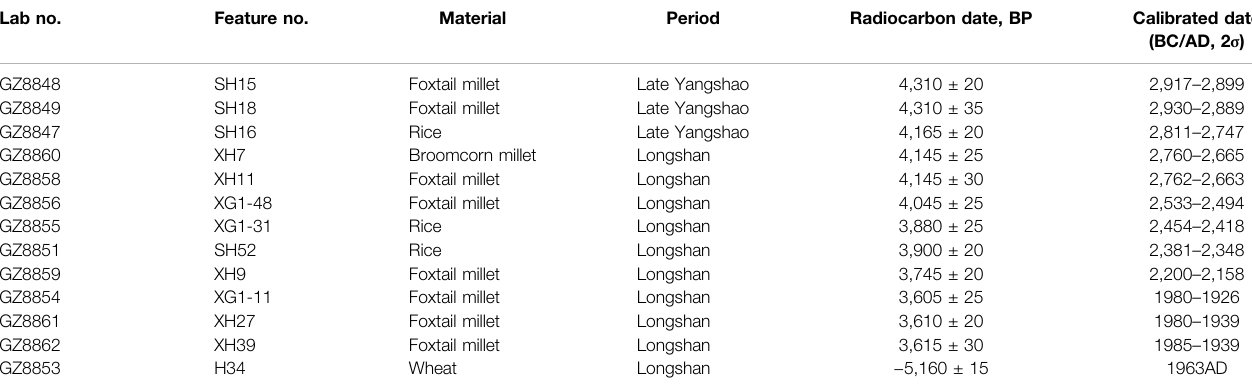
TABLE 1 | Radiocarbon dates and calibration results of the Suyang site. Lab